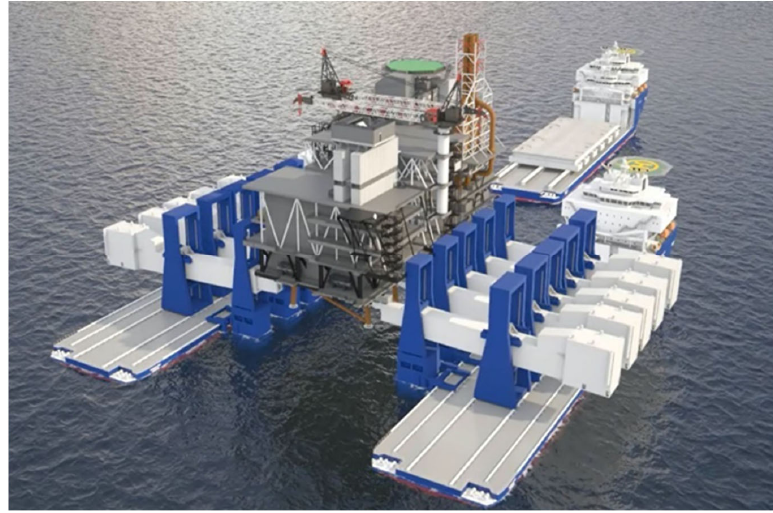
Figure 1. Double ‐ ship Integrated Offshore Platform Decommissioning Solution. Figure 1. Double-ship Integrated Offshore Platform Decommissioning Solution.